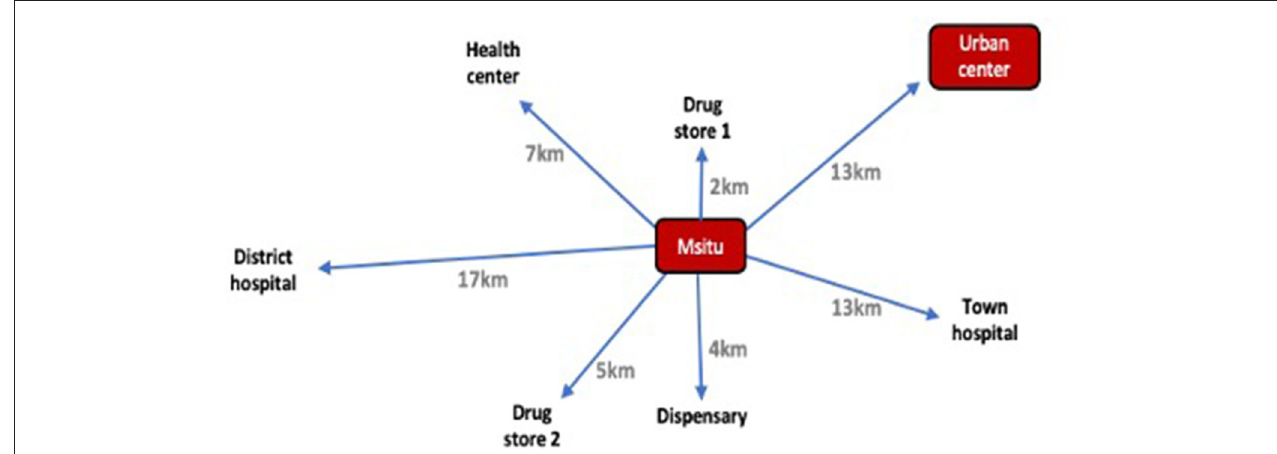
FIGURE 4 | Distribution of healthcare facilities in relation to Msitu village.